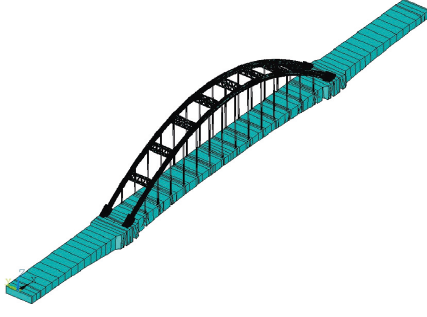
Figure 7: The FE model of the